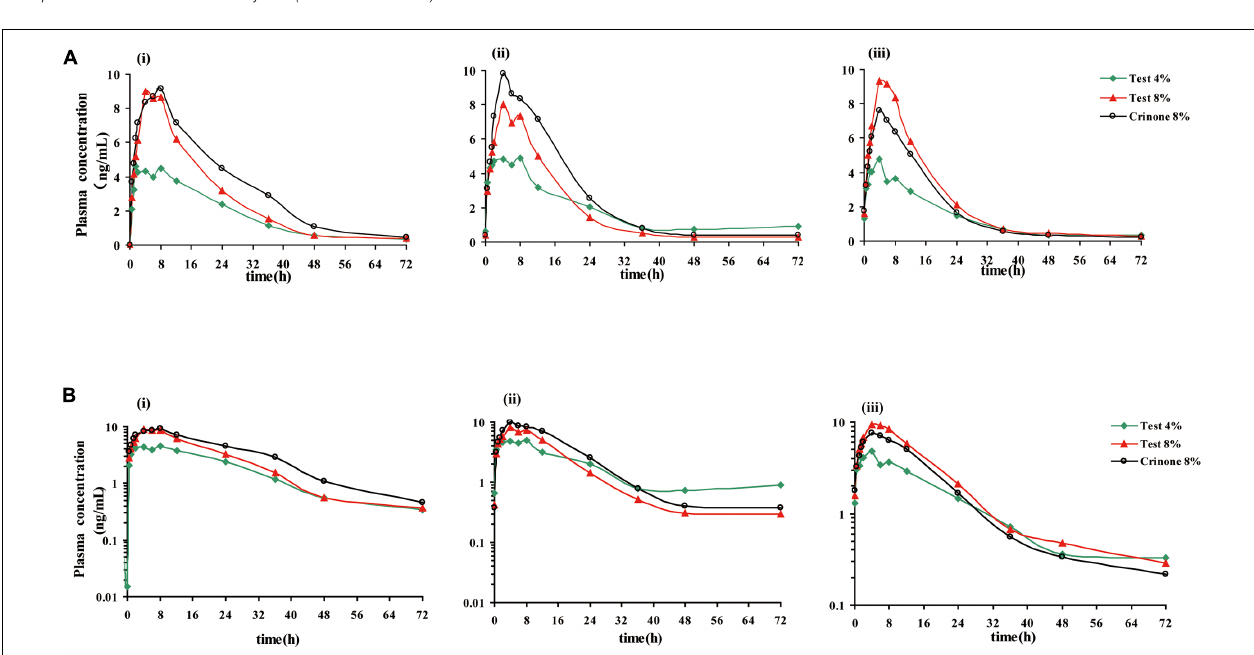
FIGURE 3 | Mean plasma progesterone concentration vs. time curves after receiving three forms of vaginal progesterone gel. Mean plasma progesterone level after single dose (i), mean plasma progesterone level following the last administration (every other day dosing, ii), mean plasma progesterone